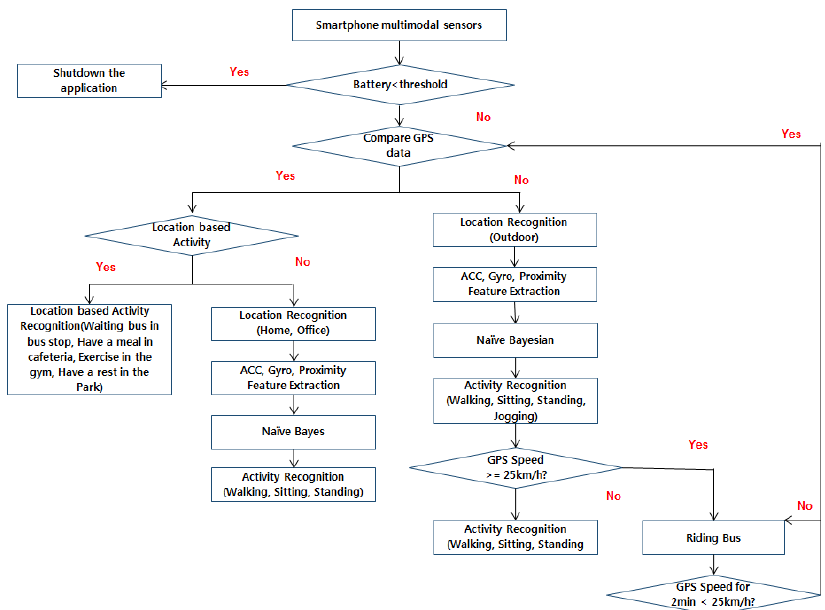
Figure 2. Flow Chart for activity